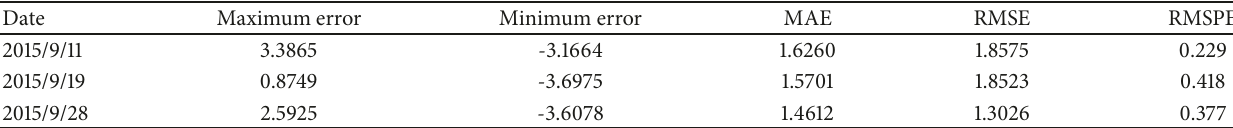
Table 5: Statistical error results of prediction.